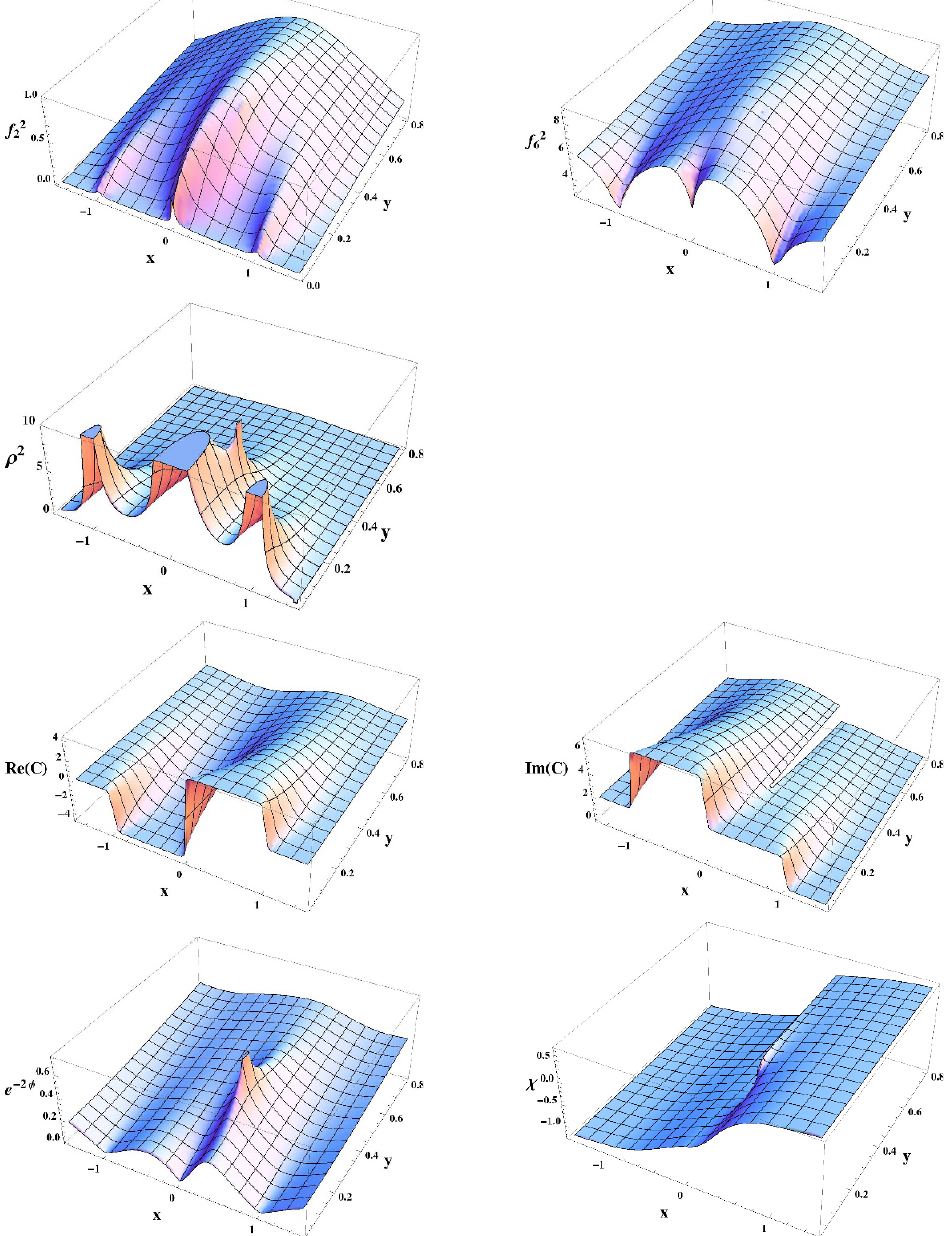
Figure 4 . The metric factors f 2 C and axion and dilaton for the 3-pole solution with [1 ; 0] branch